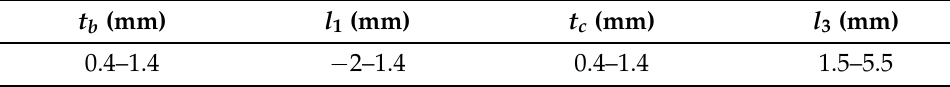
Table 1. Values of structural parameters.